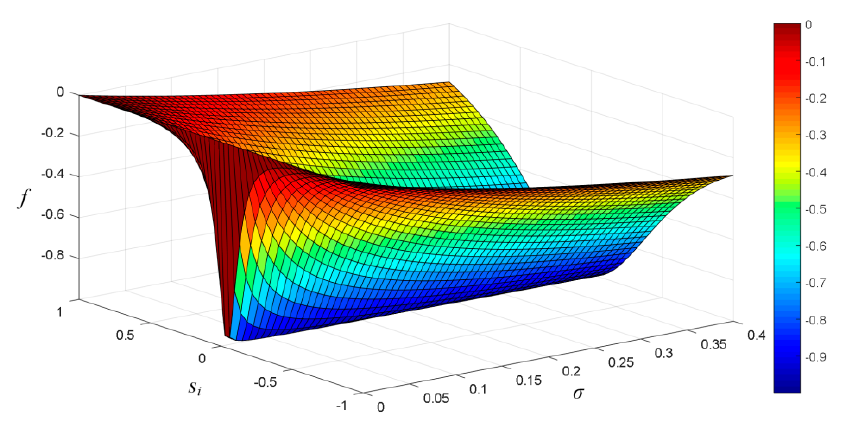
Figure 6. Surface graph of −𝜎/(𝑠 (cid:3036)(cid:2870) + 𝜎) .